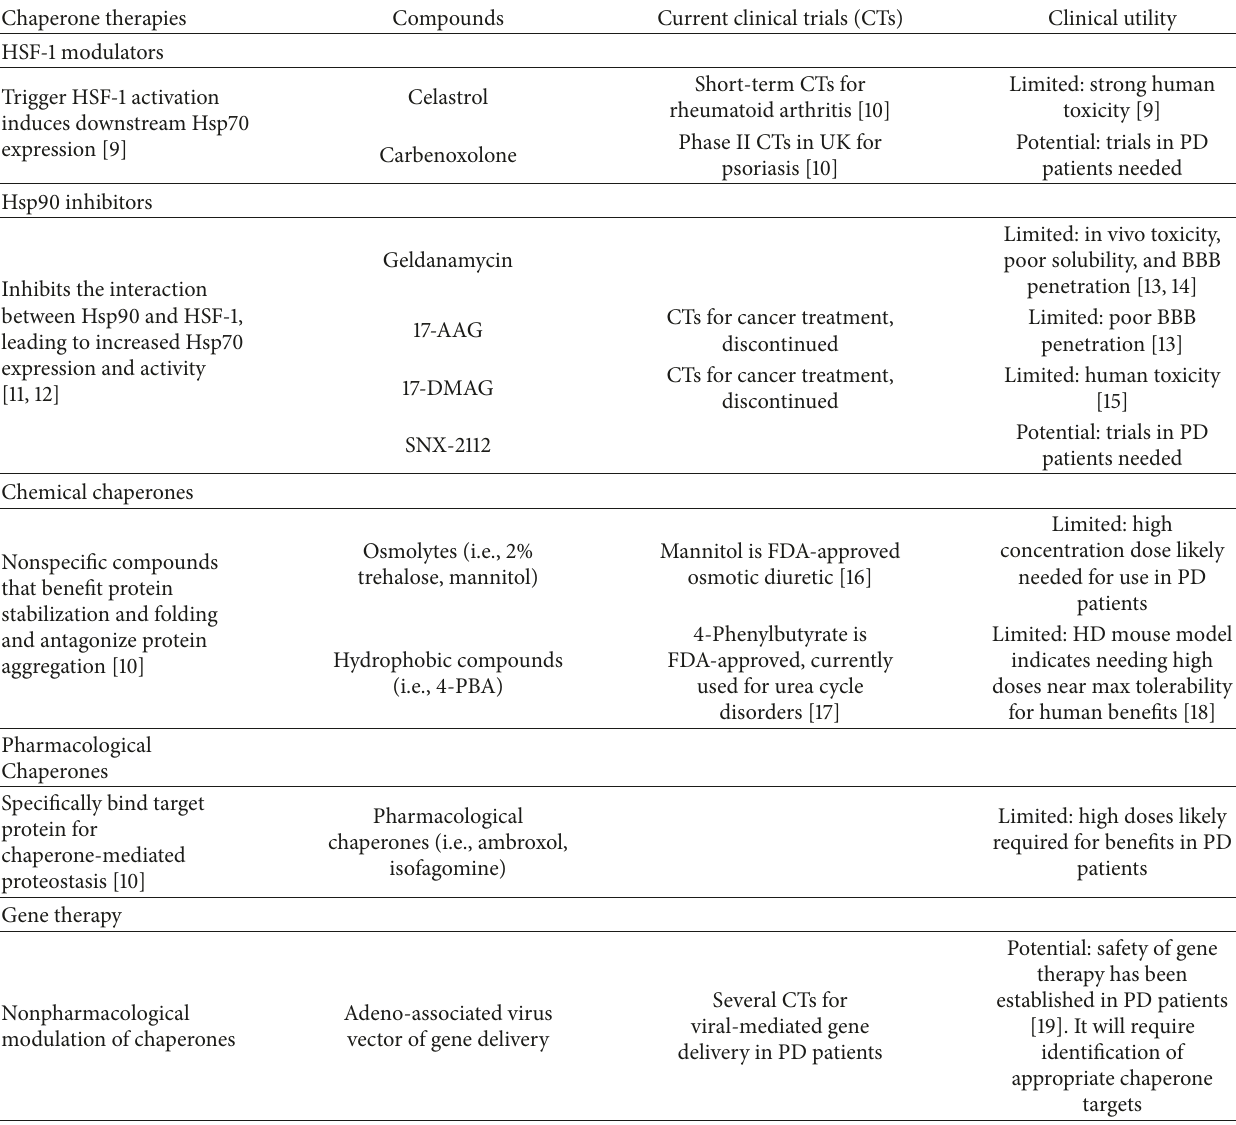
Table 1: Examples of relevant therapeutics that either target endogenous molecular chaperones, exert their own chaperone function, or have promise for applying chaperone therapies in humans and their progress in preclinical research and clinical trials (CTs). Chaperone